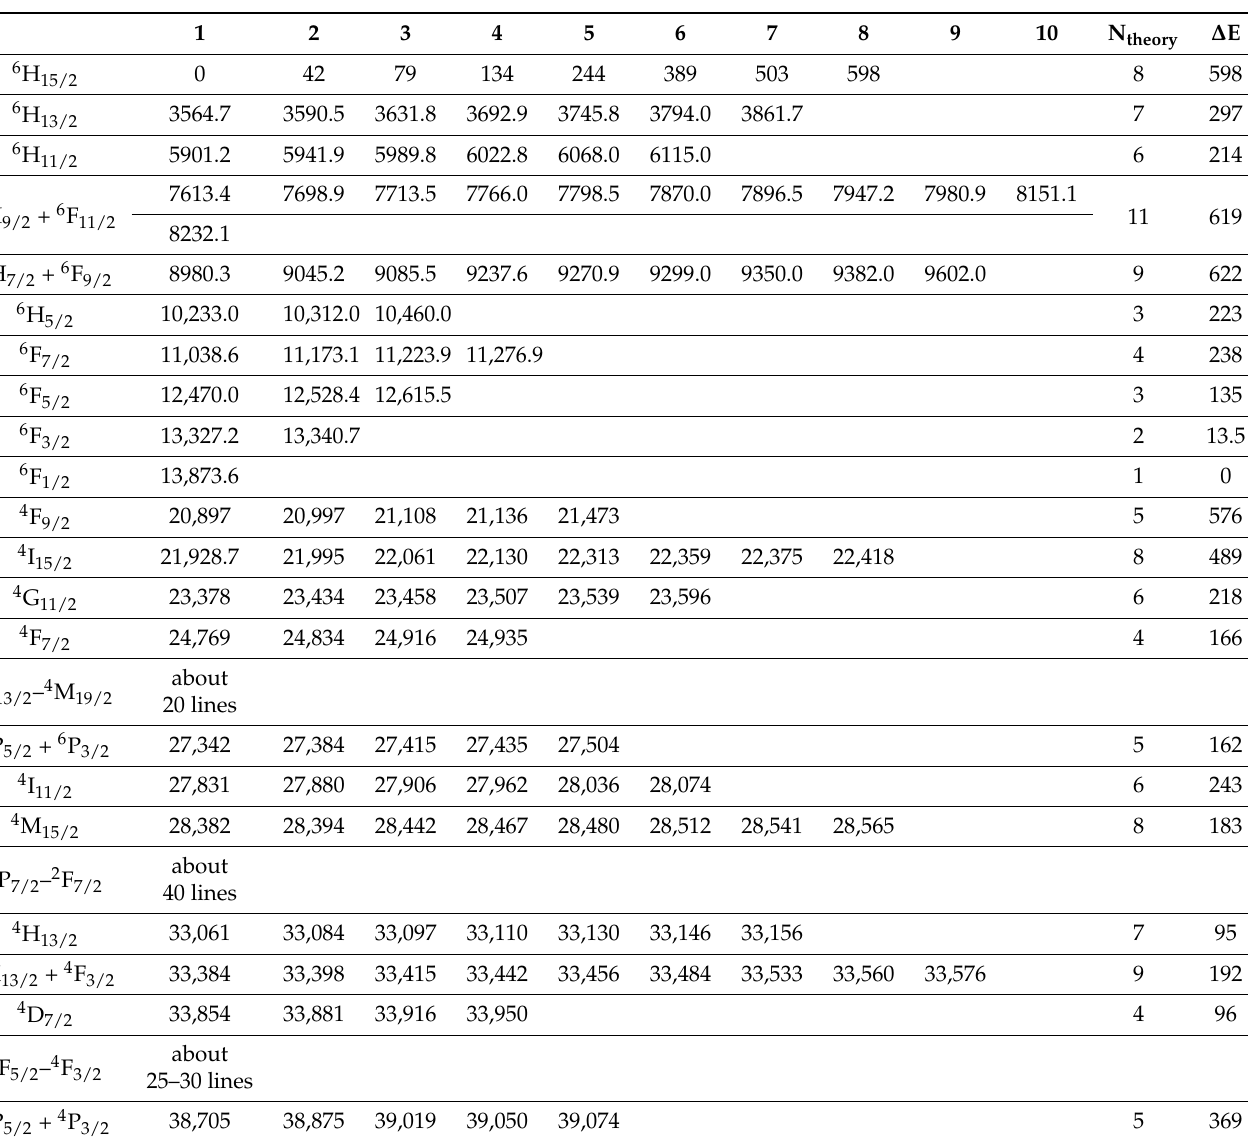
Table 1. Energy levels of Dy 3+ ions in monoclinic Li 6 Y(BO 3 ) 3 crystals (in cm − 1